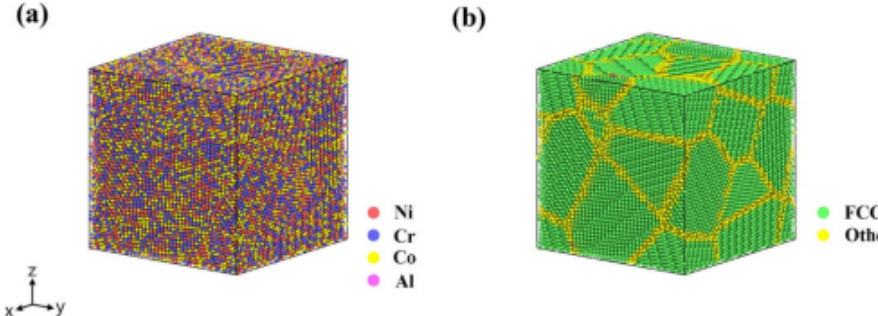
Figure 1. Polycrystalline atom model ( a ) of medium-entropy alloy CrCoNiAl 0.014 and structure identification ( b ) using Common neighbor analysis module in